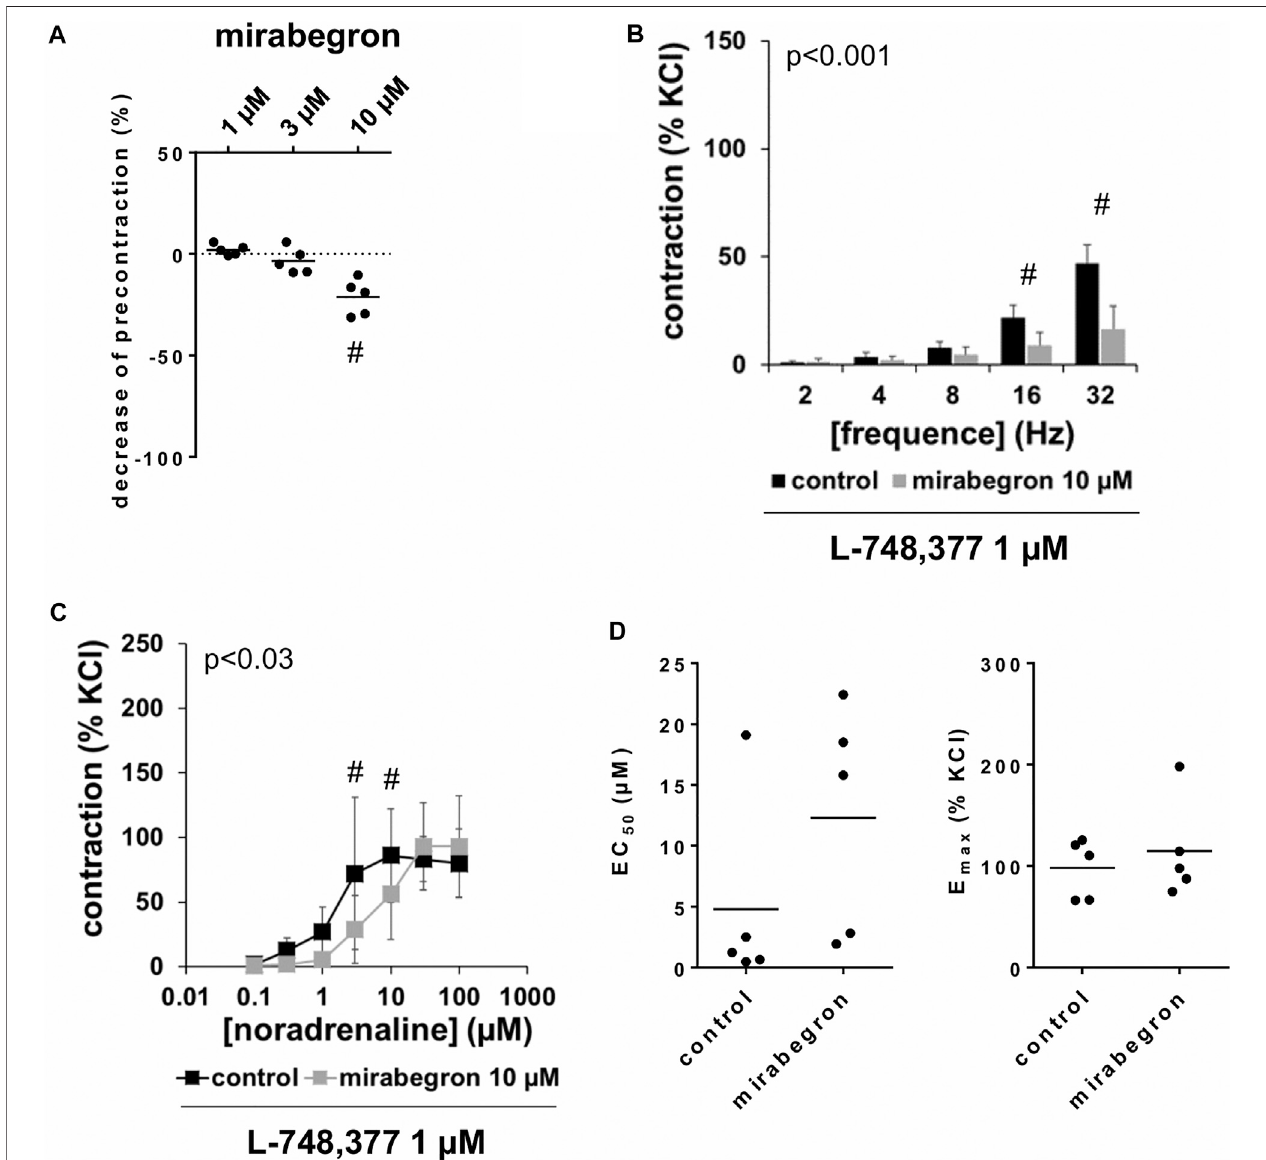
FIGURE 6 | Effects of mirabegron on KCl-precontracted human prostate tissues, and on EFS- and noradrenaline-induced contractions in the presence of L- 748,377. In (A) , prostate tissues were precontracted with 80 mM KCl. After a stable precontraction was attained, mirabegron was added in cumulative concentrations (1 – 10 µM). Shown are data from n (cid:1) 5 patients together with means, which are expressed as percentage decrease from the KCl-induced precontraction (# p < 0.05 vs. precontraction before mirabegron by Dunn ’ s test). Note that KCl-induced contractions were set to 100% and all values before mirabegron re fl ect 0% relaxation (dotted line). In (B) and (C) , contractions of prostate tissues from the periurethral zone were induced by EFS (B) or noradrenaline (C) in an organ bath, 50 min after adddition of L-748,377 (1 µM) to all tissues and 30 min after addition of mirabegron (10 µM) or an equivalent amount of DMSO (controls), which was used as solvent for mirabegron.Shown aredatafrom n (cid:1) 5patients ineach diagram, whicharemeans ± SDinfrequencyresponse curves(# p < 0.05forcontrolvs. mirabegronbytwo-way ANOVA, and p values for whole groups in inserts from 1-way ANOVA).